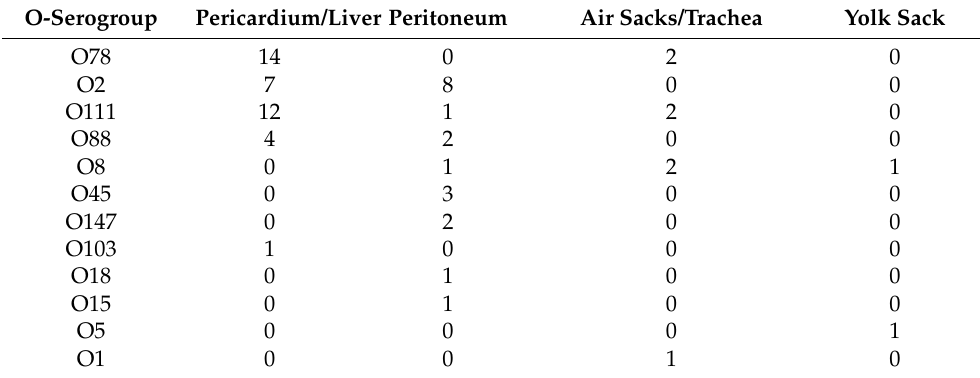
Table 5. Distribution of E. coli serogroups in relation to organ origin(number of strains).